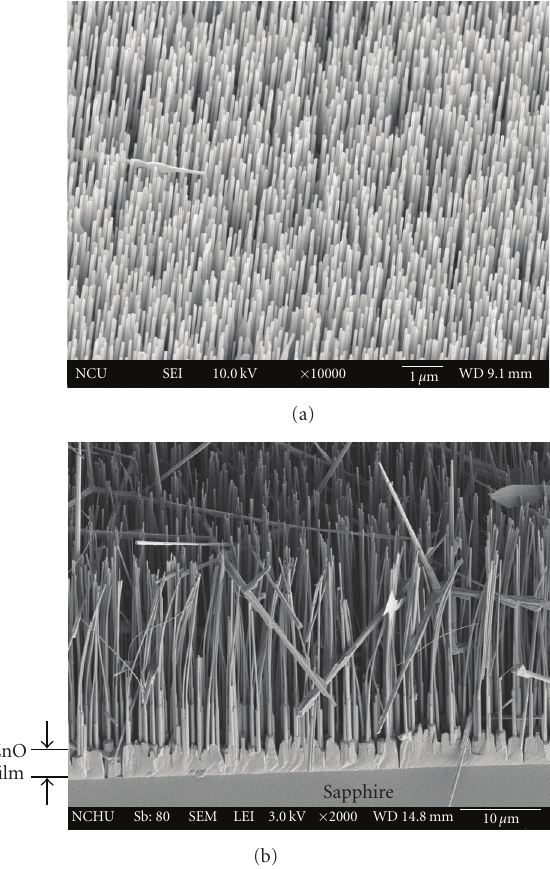
Figure 2: SEM images: (a) top view, (b) cross-sectional view, of ZnO nanorods on top of a ZnO film grown by the one-step CVD